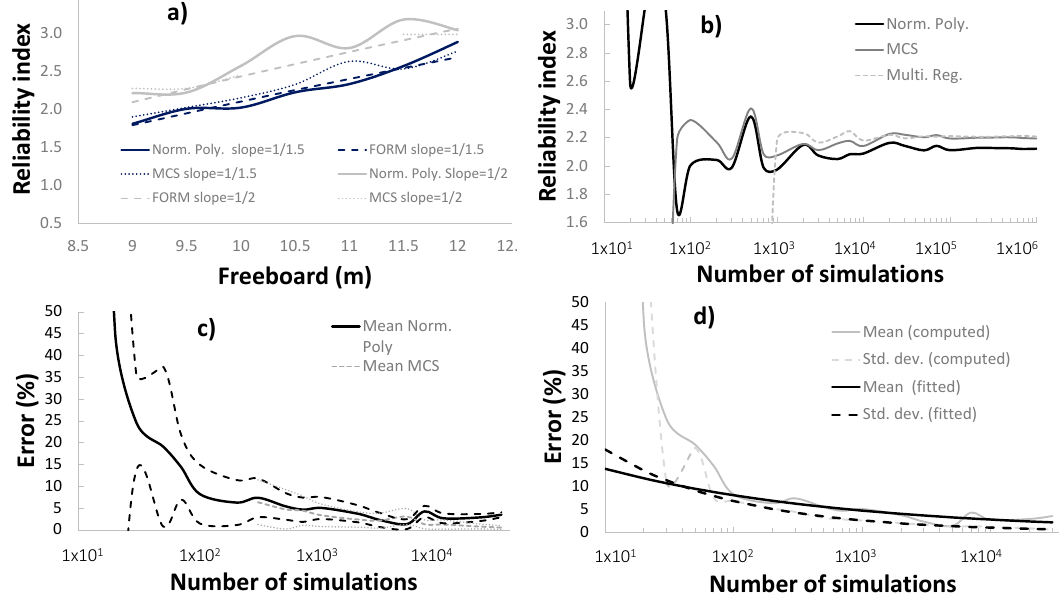
Figure 5. Reliability of breakwater and error estimation in the reliability index. ( a ) Reliability index as a function of F c ; ( b ) Reliability index as a function of n sim ; ( c ) Computed error for the reliability index; ( d ) Fitted mean and standard deviation for the error in the reliability index estimation.